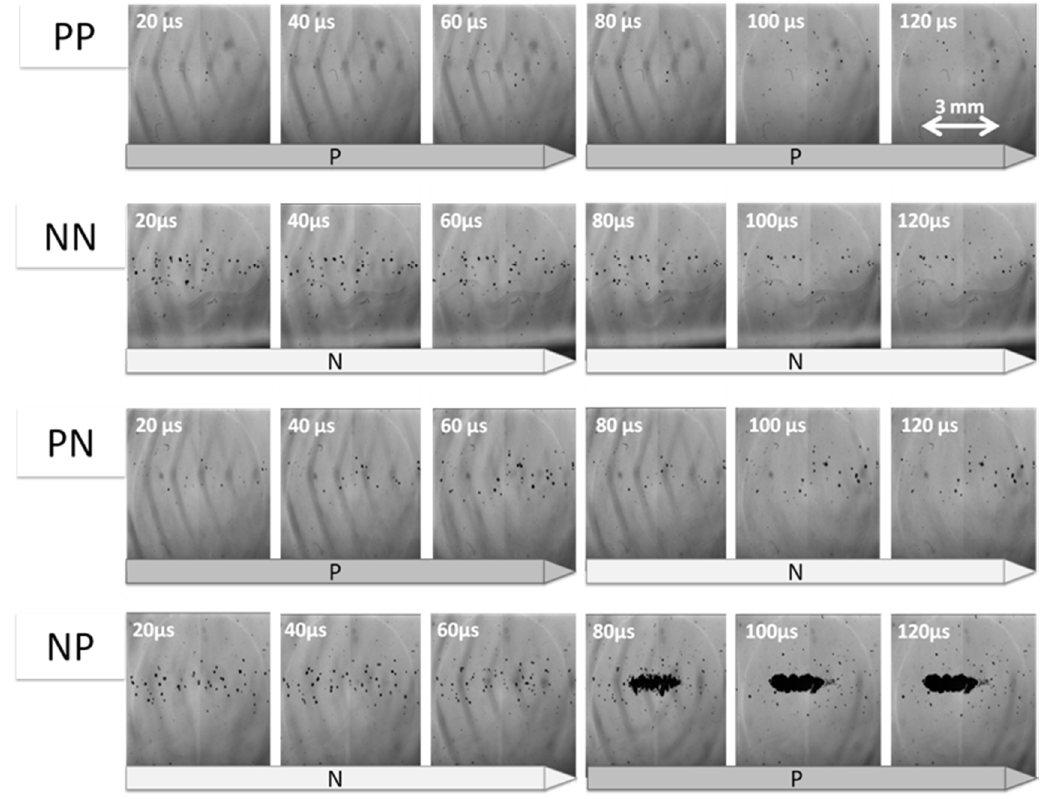
Figure 4. High-speed images of generated cavitation bubbles in a poly(acryl amide) (PAA) gel including 22.5% bovine serum albumin (BSA) by each sequence at an ultrasound intensity of 42 kW/cm 2 [54]. The frame rate was 500 kfps with an exposure time of 250 ns.